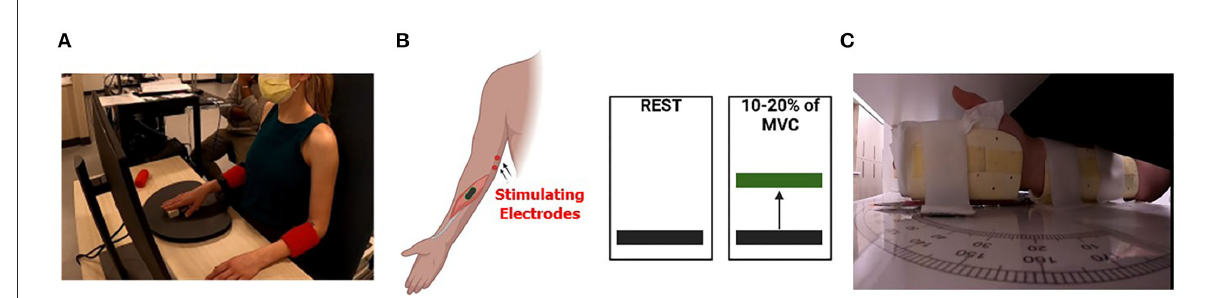
FIGURE1 Experimental setup. (A) Depiction of the experimental setup where the participant is seated in a chair and viewing the wrist flexion muscular performance level on a computer screen as they attempt to match the prescribed targets. The tested arm was secured to reduce extraneous motion and the subject’s wrists were in prone position. (B) A cartoon depicts the concept of the visual feedback displayed for subjects during the isometric wrist flexion task. Subjects were tested at rest (left) and during 10 to 20% (right) of maximal voluntary contraction (MVC). (C) Depiction of the positioning of the wrist within the wrist position sense test apparatus. The subject’s vision of wrist position was occluded, and a black pointer located on top of the apparatus (not shown) was used by the participant to indicate the perceived wrist